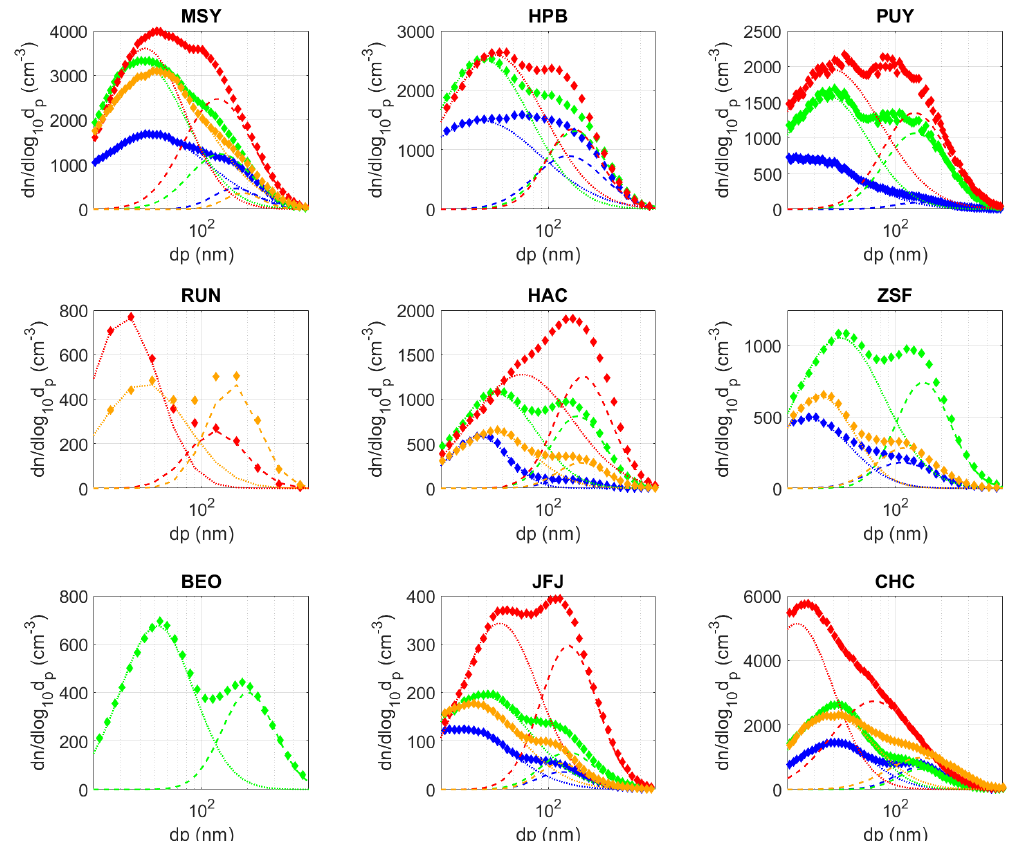
Figure A6. Median particle size distributions (diamonds) and corresponding modes (dotted lines) at mountain sites. See Fig. A1 for an explanation of the